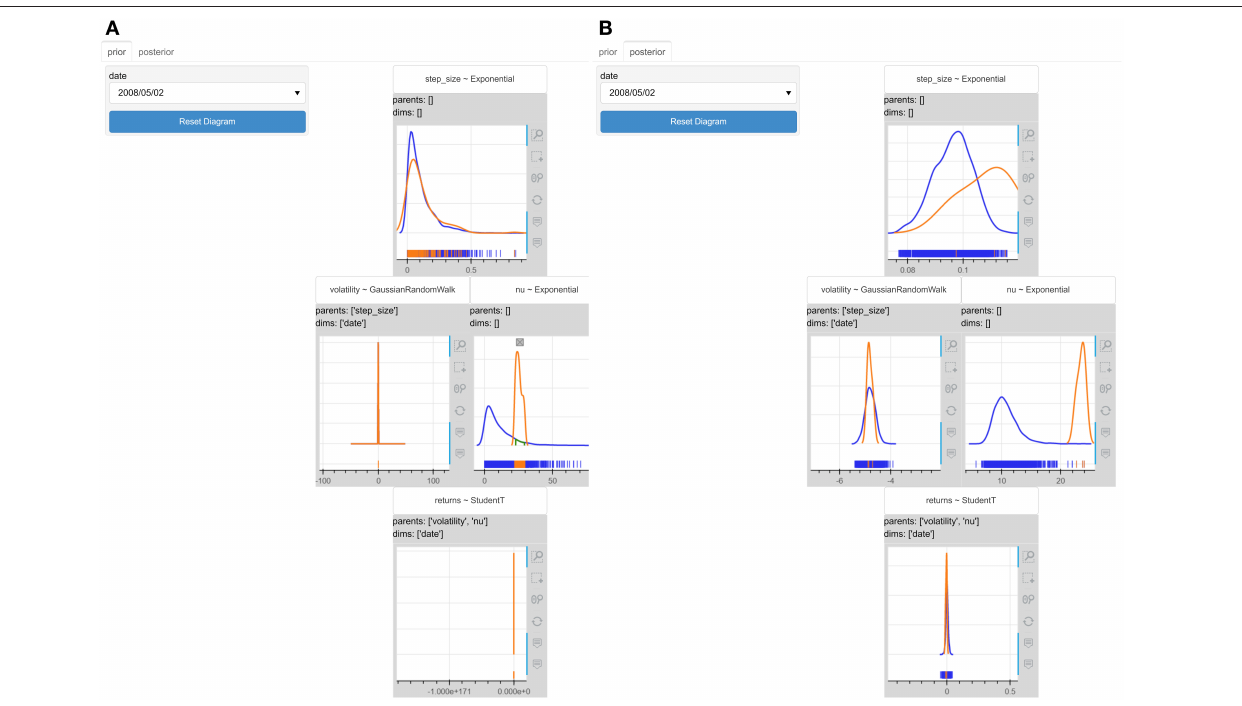
FIGURE 11 | The interactive probabilistic models explorer of the stochastic volatility model where we set the condition ν ∈ [21.0,30.0]. (A) The prior graphical representation. (B) The posterior graphical representation. The posterior distribution of volatility and the posterior predictive distribution of returns become tighter. More informative priors make model be more certain about its